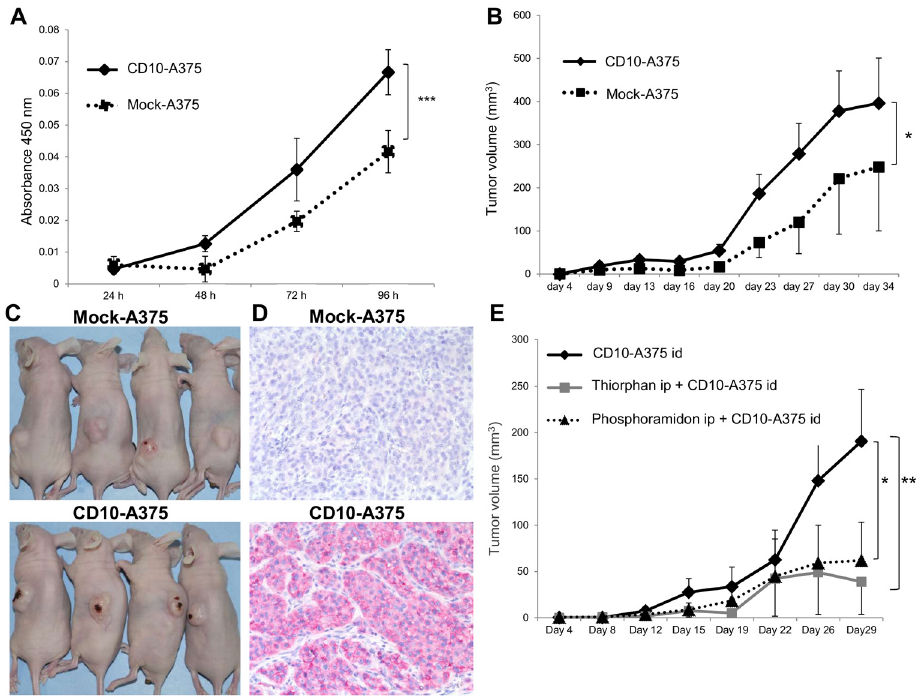
Fig 2. CD10 promotes in vitro cell proliferation and in vivo tumor growth, but its tumorigenic effect can be suppressed by CD10 enzymatic inhibitors. (A) CD10 expression promotes the proliferation of A375 melanoma cells in vitro . Growth curves of CD10-A375 (solid line) and mock-A375 (dotted line) cells grown in 5% FBS ( n = 3 per group) show that CD10 expression increases cell growth. Cells were plated in triplicate in 96-well plates and incubated for 24, 48, 72, or 96 hours, and the number of viable cells was assessed, as described in Materials and Methods. Points, mean ( n = 3); bars, SD. Cell proliferation rate was significantly higher in CD10-A375 (solid line) than in mock-A375 (dotted line). Representative data of three independent experiments are shown. (B) Effect of CD10 overexpression by A375 cells on tumor growth in a xenograft